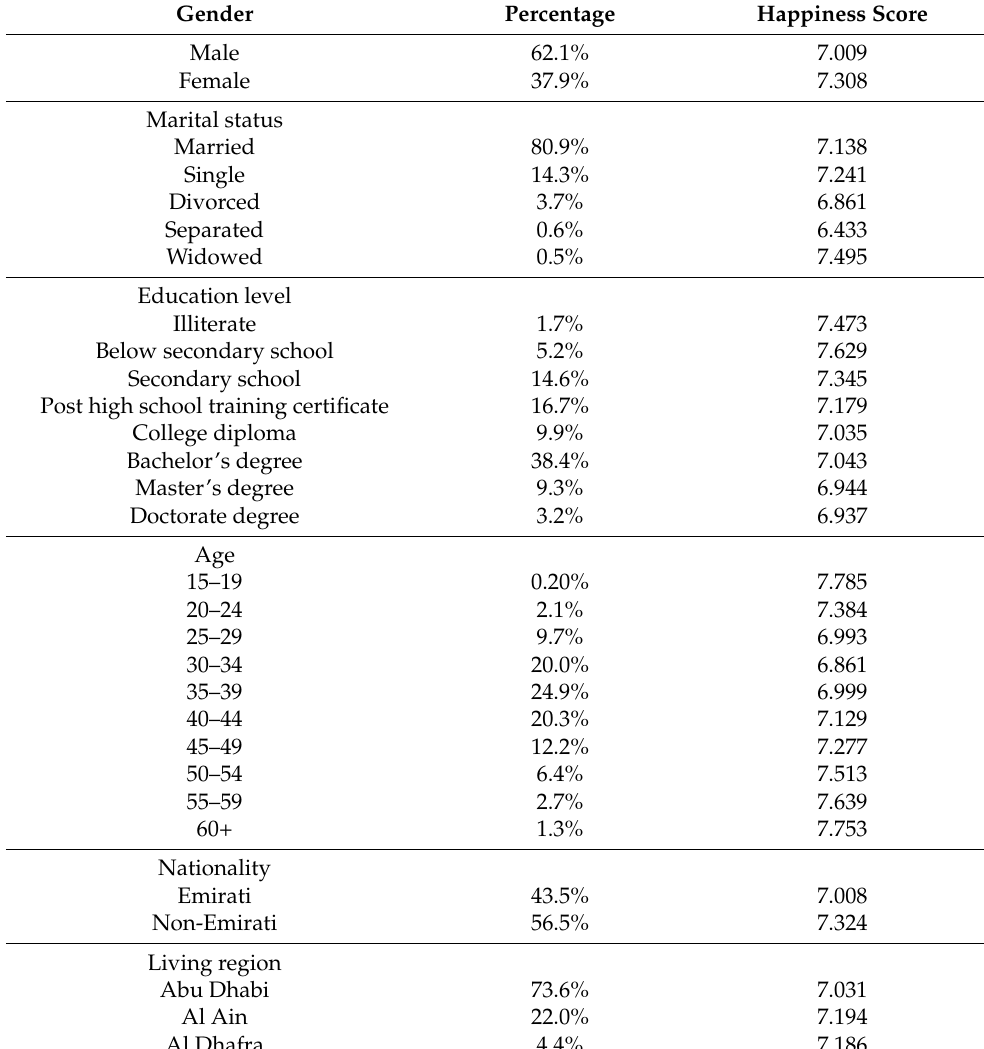
Table 2. Respondent’s profile.